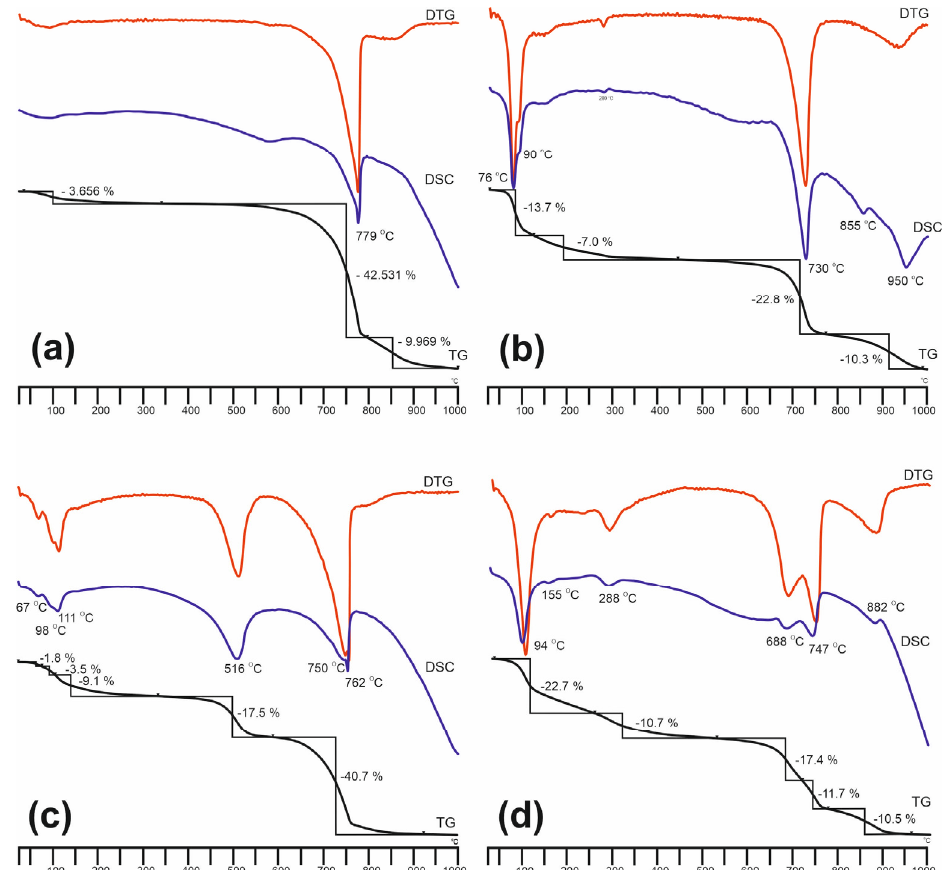
Figure 9. Thermal behavior of sulfate minerals. ( a ) millosevichite, ( b ) steklite, ( c ) godovikovite, ( d ) unnamed MgSO 4 .